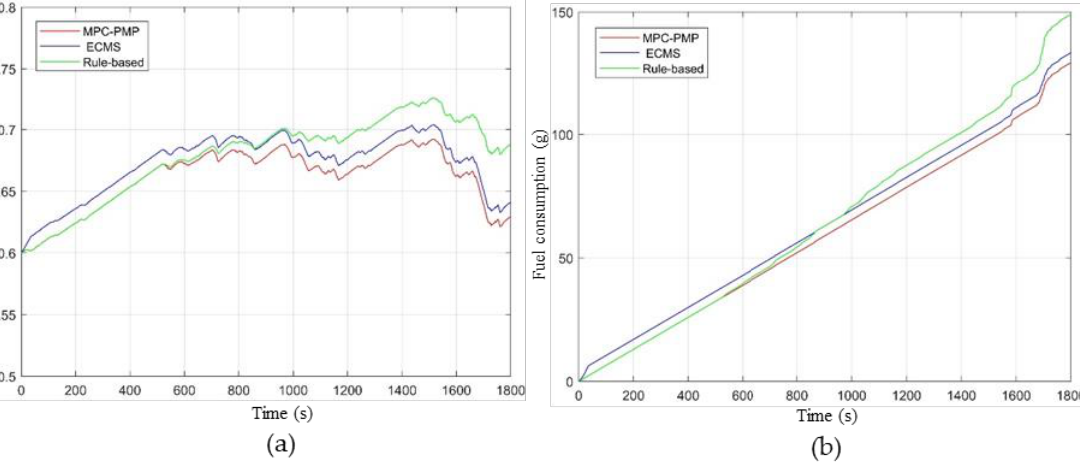
Figure 12. Optimized results under CLTC conditions: ( a ) SOC waveform of battery; ( b ) fuel consumption.